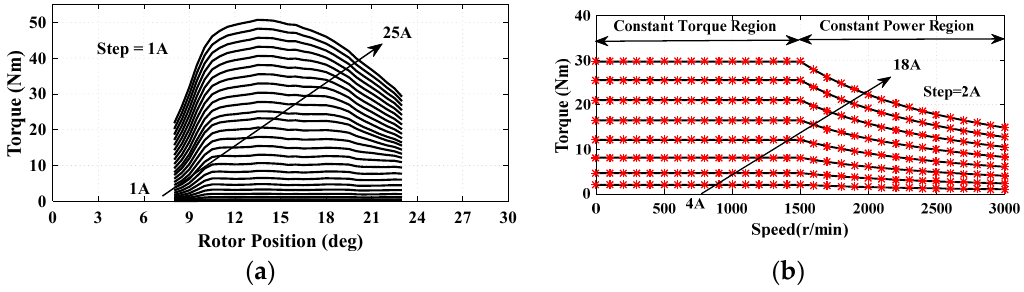
Figure 5. The torque curves: ( a ) over the most efficient angle (15°); ( b ) versus speed.